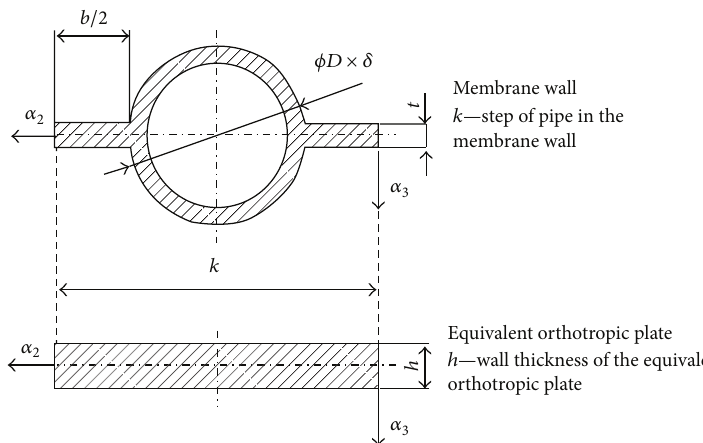
Figure 3: Geometry of cross-section of membrane wall and equivalent orthotropic plate.